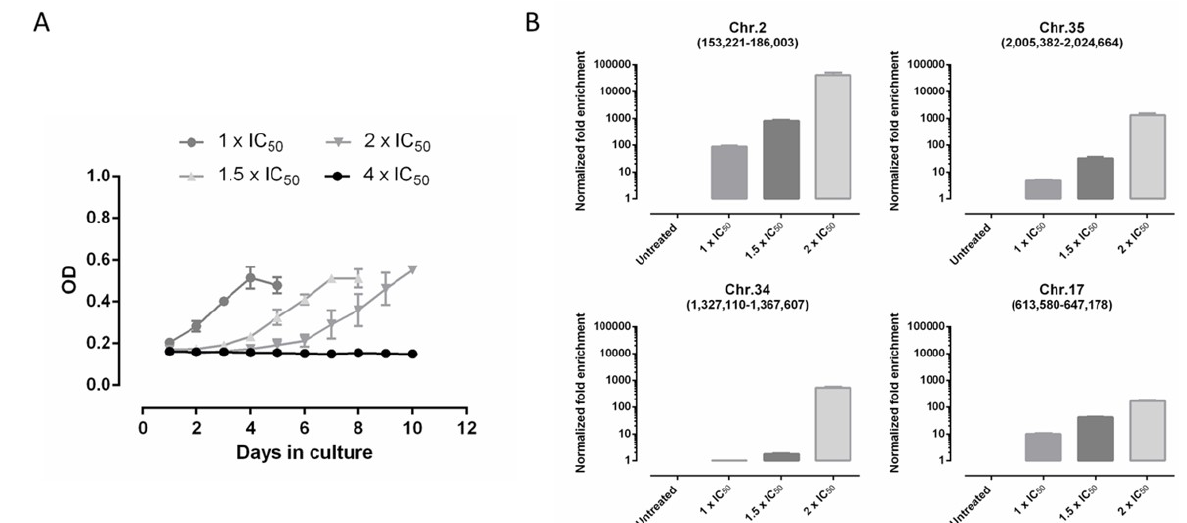
Figure 2. Overview of the Cos-Seq L. infantum library selection and bio-analysis. ( A ) Growth curves of parasites transfected with the cosmid library in the presence of increasing concentrations of DNDI-6148. Results are expressed as mean optical density (OD) ± SEM, and are based on two biological repeats. ( B ) Normalized fold enrichment for the most highly enriched cosmids after selection with DNDI-6148. The chromosomal and genomic locations of genomic DNA fragments maintained by enriched cosmids are given. Table 2. Overview of the gene functions of the isolated cosmid-harboring genes from chromosome 2. Cosmid Gene